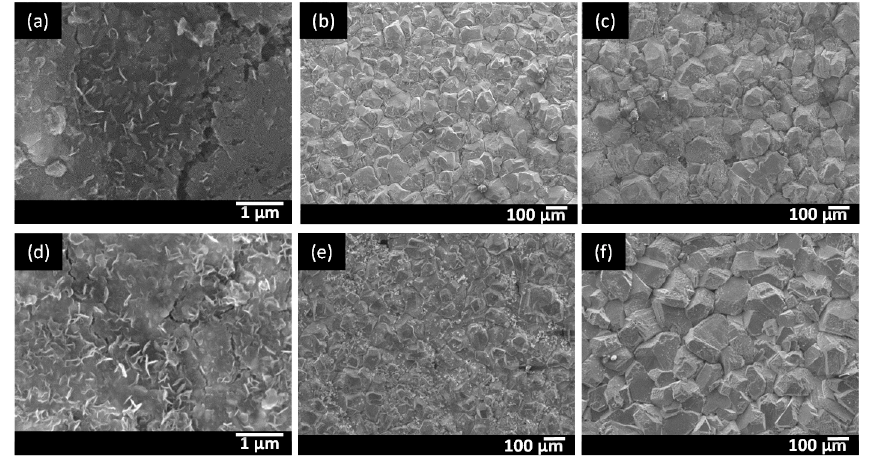
Figure 1. Top view images of the low Mo (A) material after ( a ) 3 days, ( b ) 14 days, and ( c ) 28 days and of the high Molybdenum (Mo) material after ( d ) 3 days, ( e ) 14 days, and ( f ) 28 days.